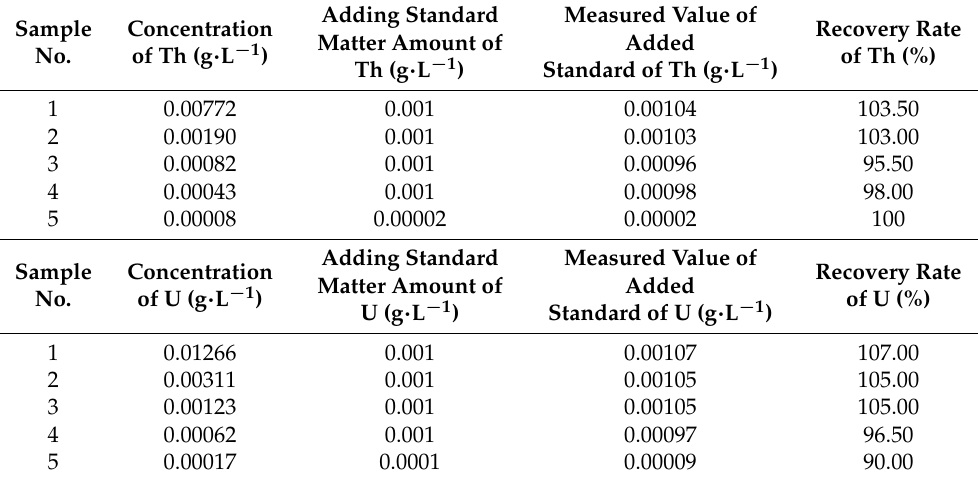
Table 4. Th and U test results of spiked recovery